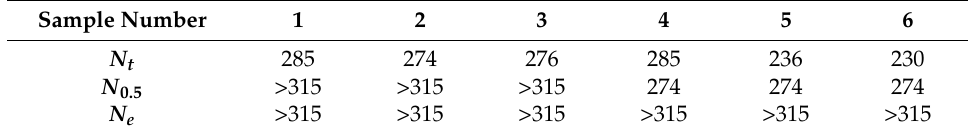
Table 7. The number of cuts corresponding to the failure threshold.